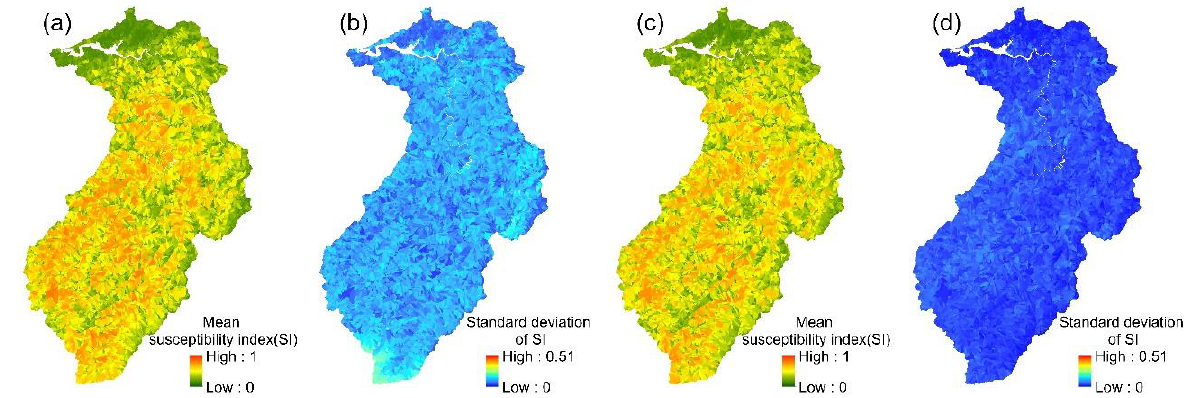
15 of 26 Figure 8. GBDT models: ( a , b ) the mean susceptibility index and standard deviation of 24 event- based models; ( c , d ) the mean susceptibility index and standard deviation of the multi-year model. 4.2. Results of Ensemble Models After establishing the single models, this study used the PM, PME, PMW, and CA ensemble methods to aggregate the landslide susceptibility indices of each single model for each event, yielding the landslide susceptibility indices of the 4 ensemble models. The spatial variation in each event's landslide susceptibility index could be obtained from the 24 event-based PM ensemble models. The mean values and standard deviations of